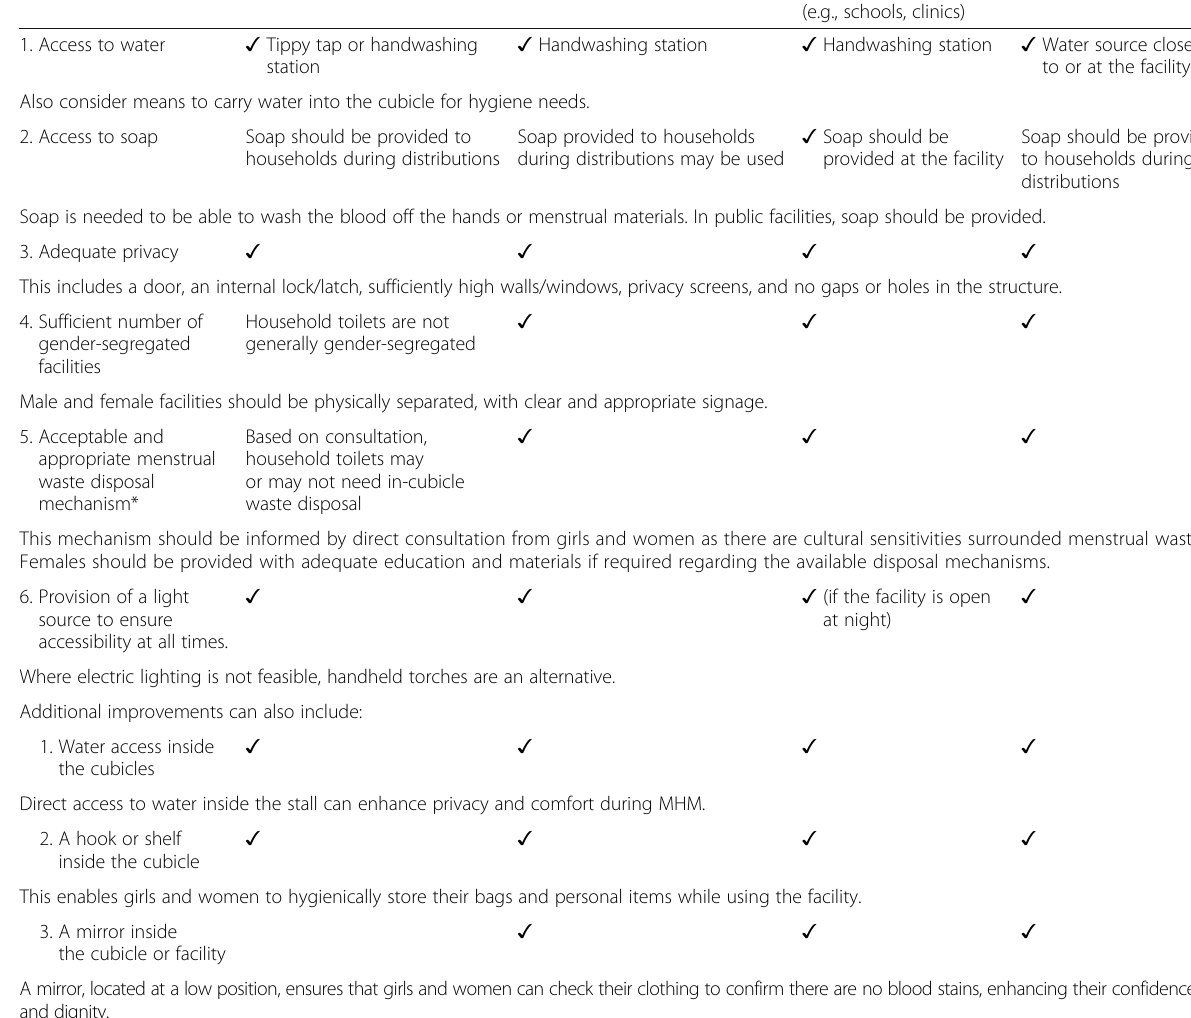
Table 4 Minimum requirements for female-friendly facilities Household Toilets Communal